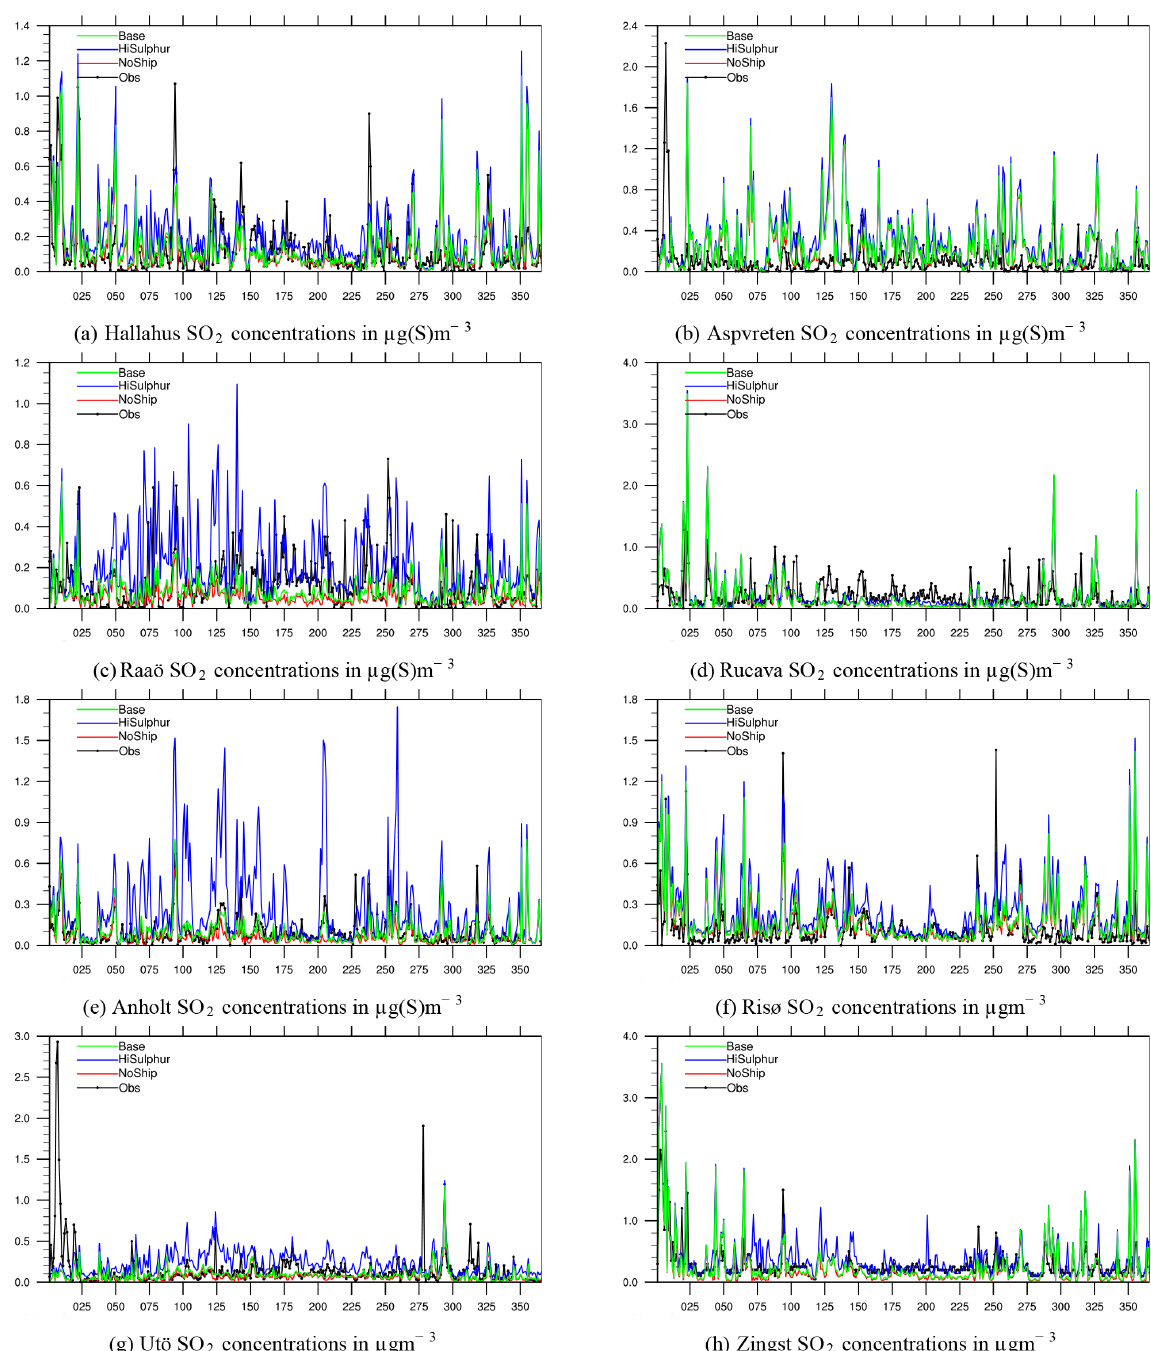
Figure A3. Measured and model-calculated present (2016) concentrations of SO 2 . Present model-calculated results are shown for the Base, HiSulphur, and NoShip